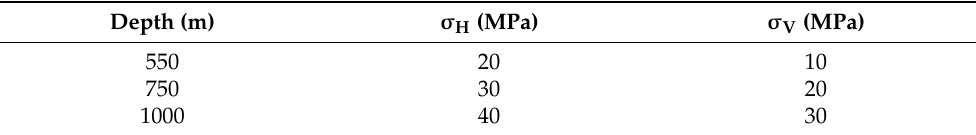
Figure 7. Calibration results. ( a ) Intact rock; ( b ) Rock with structural plane. Table 3. Microscopic parameters in PFC. Table 4. Geo-stress applied in PFC.